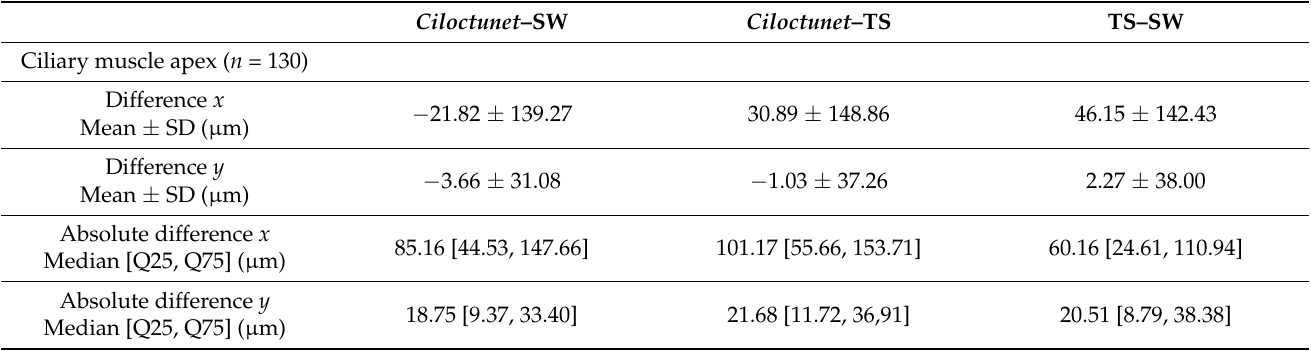
Figure 4. Distribution of the differences of the x / y -coordinates of the ciliary muscle apex and the scleral spur between different pairs of segmentation and the corresponding 95% density ellipses (red: Ciloctunet vs. SW; blue: Ciloctunet vs. TS; green: SW vs. TS). The density plots depict the shape of the distribution of the differences between the x - and y -coordinate of the respective pairs of segmentations. Table 2. Descriptive statistics of the differences of the respective x / y -coordinates of the ciliary muscle apex and the scleral spur between different pairs of segmentations.